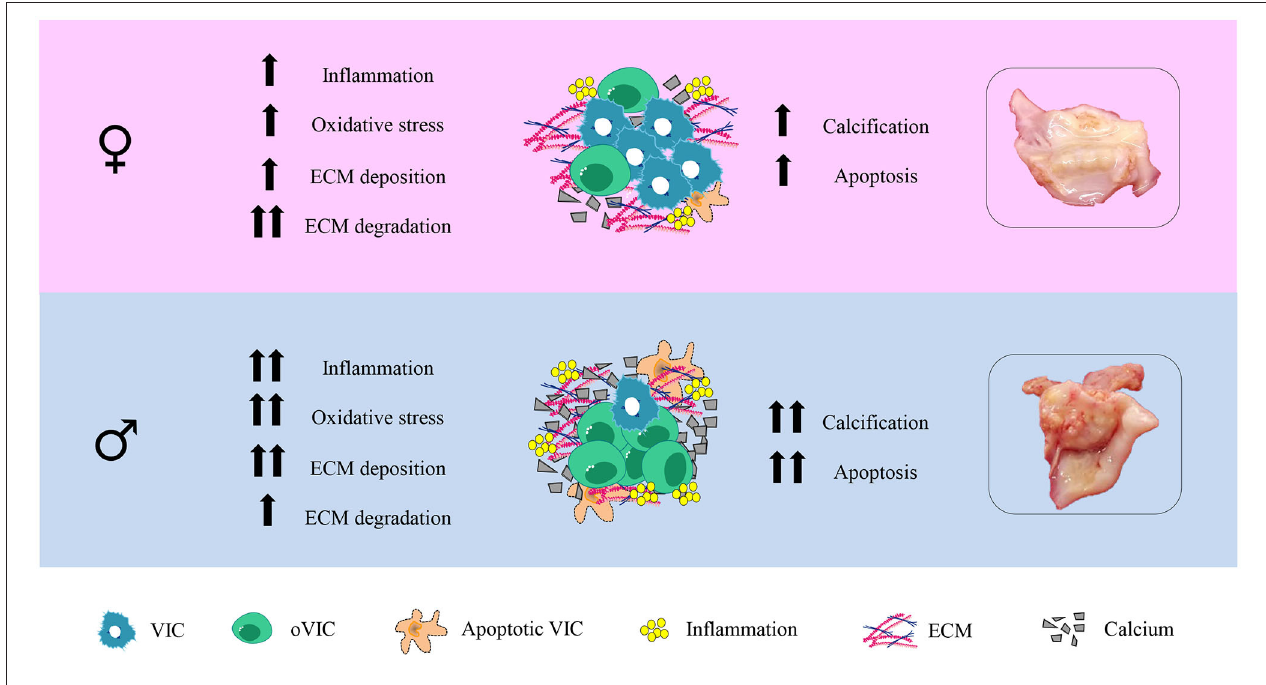
FIGURE 5 | Graphical